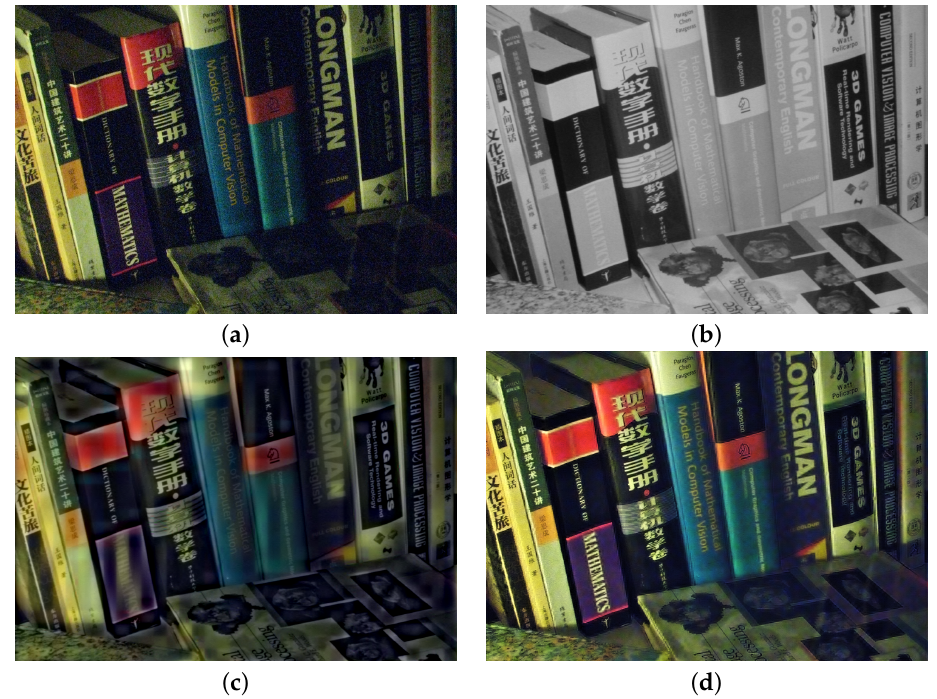
Figure 2. Fusion and denoising results in Books by Guided Wavelet Shrinkage (GWS) [1]. ( a ) RGB image. ( b ) NIR image. ( c ) GWS. ( d ) Proposed